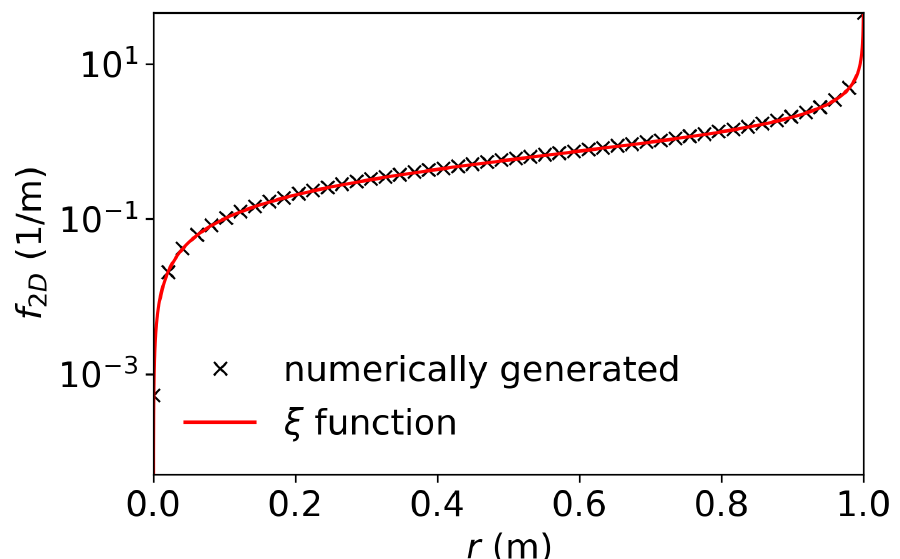
Figure 3. Comparison of the numerically and analytically generated f 2D distribution functions Equation (15) for a monodisperse particle ensemble.